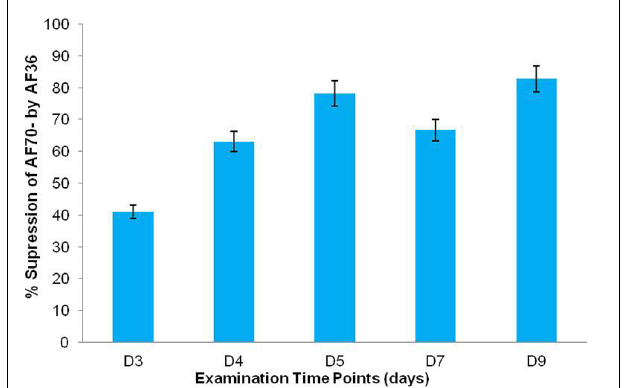
FIGURE 4 | Percent (%) growth suppression ofAF70-GFP byAF36 in co-inoculated corn kernels as determined by calculating the percent difference between treatment means on a particular day. Over 5% difference in suppression was observed between consecutive time points (day 3–day 9).